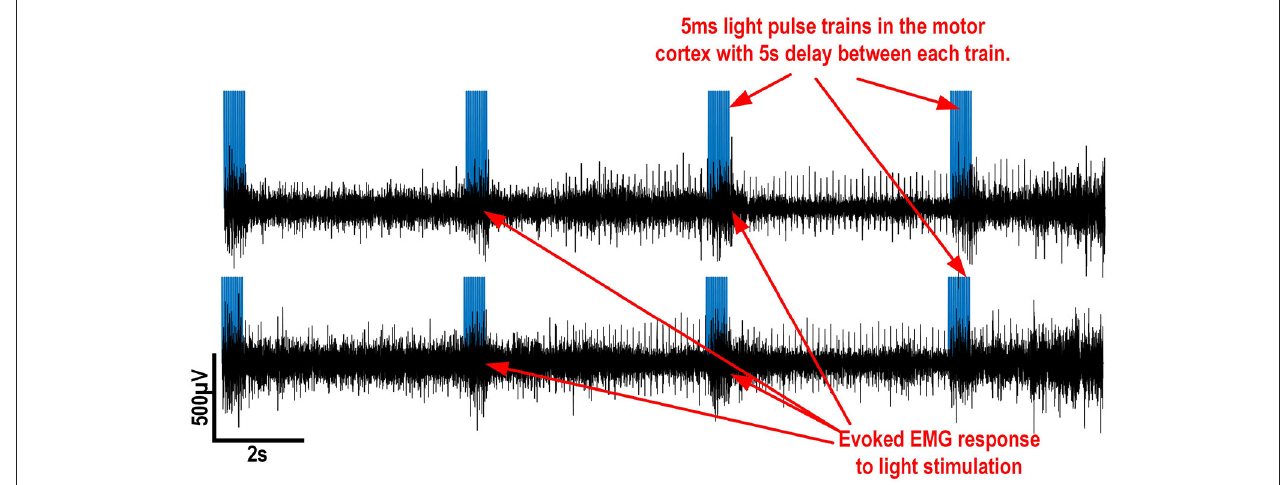
FIGURE 12 | In vivo EMG recording in the extensor carpi radialis and flexor carpi radialis muscles of a freely moving rat. The stimulation trains are shown in blue to show when a response should be